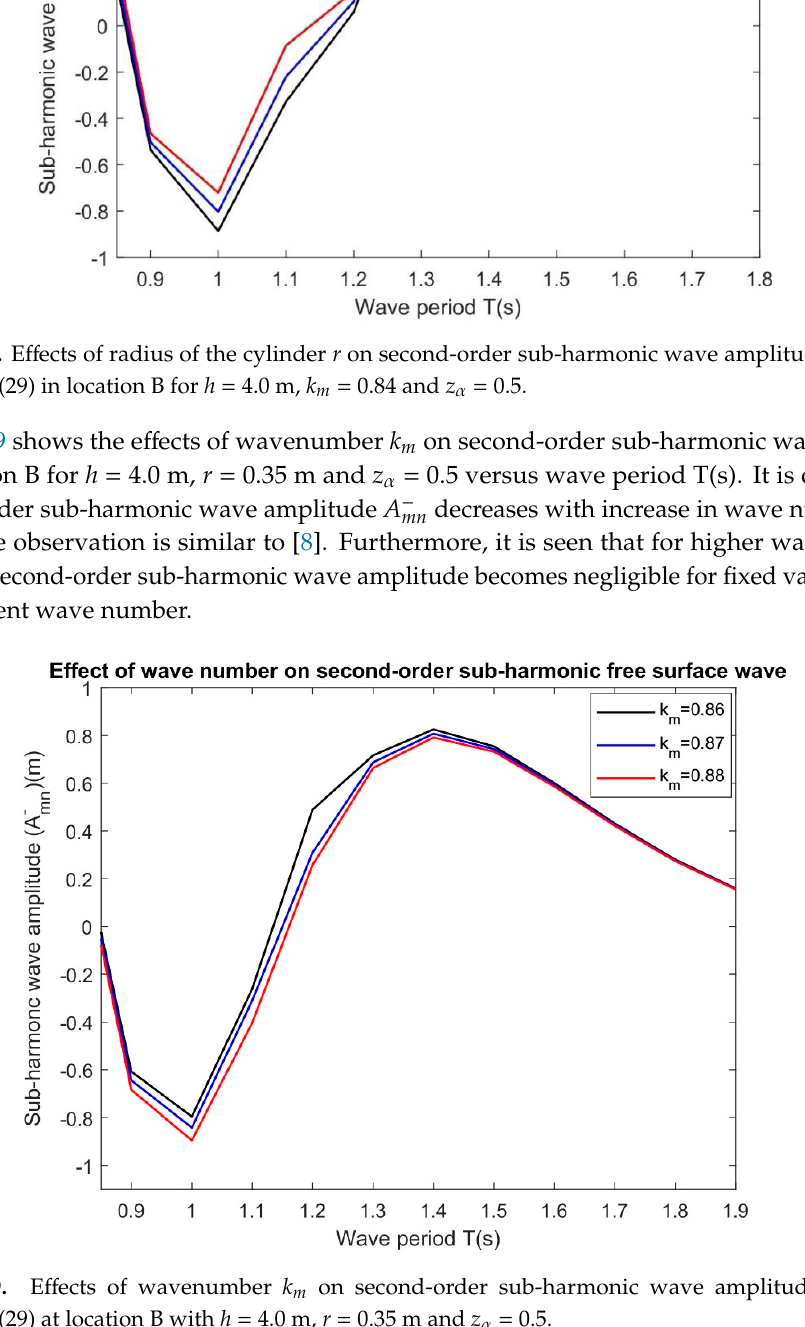
Figure 19. E ff ects of wavenumber k m on second-order sub-harmonic wave amplitude A − mn of Figure 19. Effects of wavenumber k m on second-order sub-harmonic wave amplitude mn A Equation (29) at location B with h = 4.0 m, r = 0.35 m and z α = Equation (29) at location B with h = 4.0 m, r = 0.35 m and z α = 0.5.